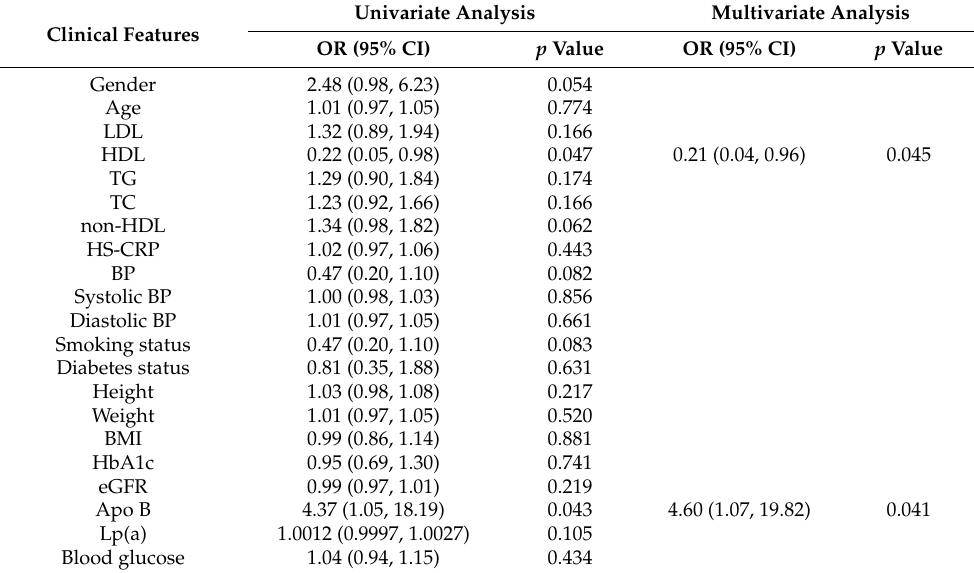
Table 2. Candidate clinical predictors after logistic regression analysis.